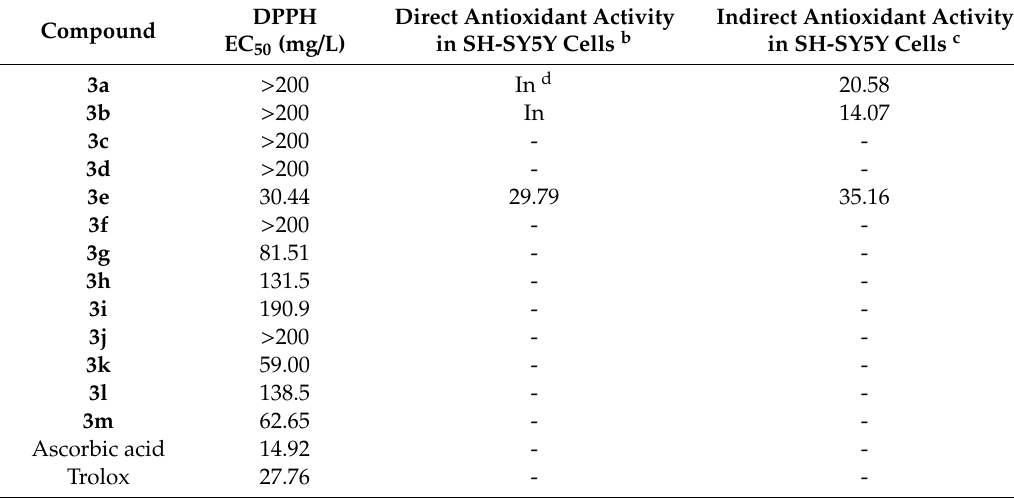
Table 3. Antioxidant activity of compounds against the DPPH radical and ROS formation induced by t -BOOH in neuronal SH-SY5Y cells a